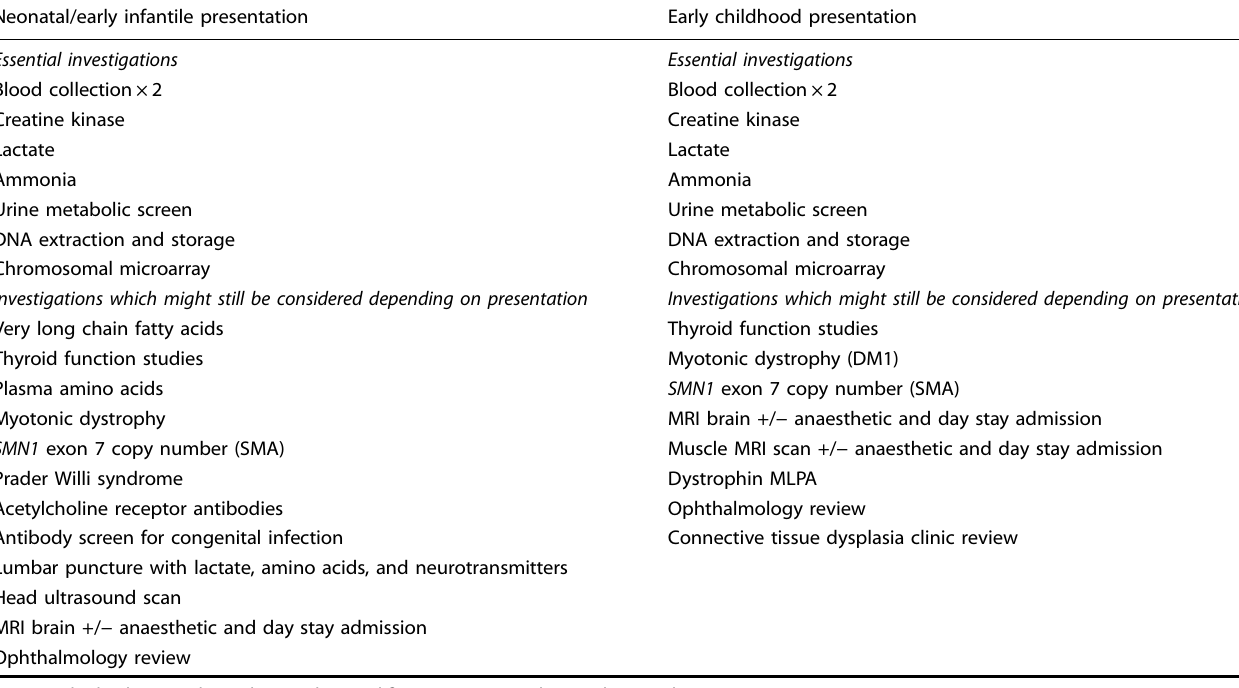
Table 2. Essential and recommended investigations used for assignment of counterfactual costs Neonatal/early infantile